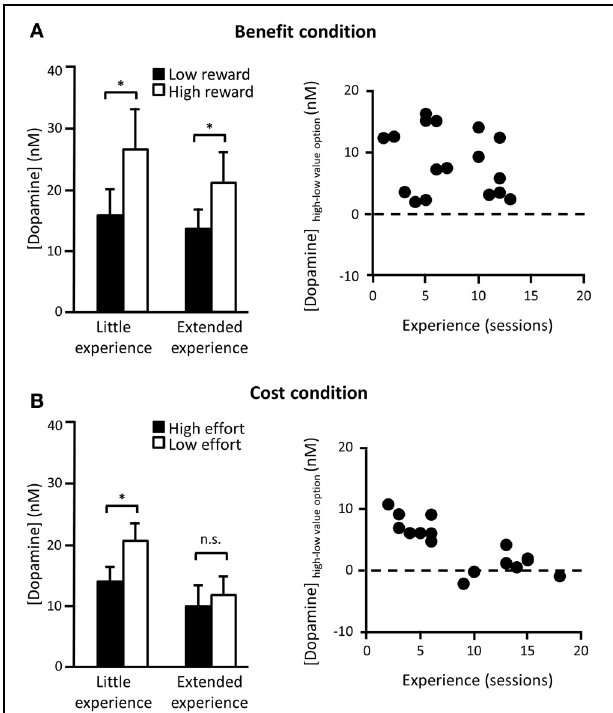
FIGURE 1 | Cue-elicited dopamine release in NAc core during a two-option decision making task. (A) Left panel: Average (mean + s.e.m.) phasic dopamine release in NAc core elicited by cues signaling availability of either a known low (2 pellets) or a high reward (4